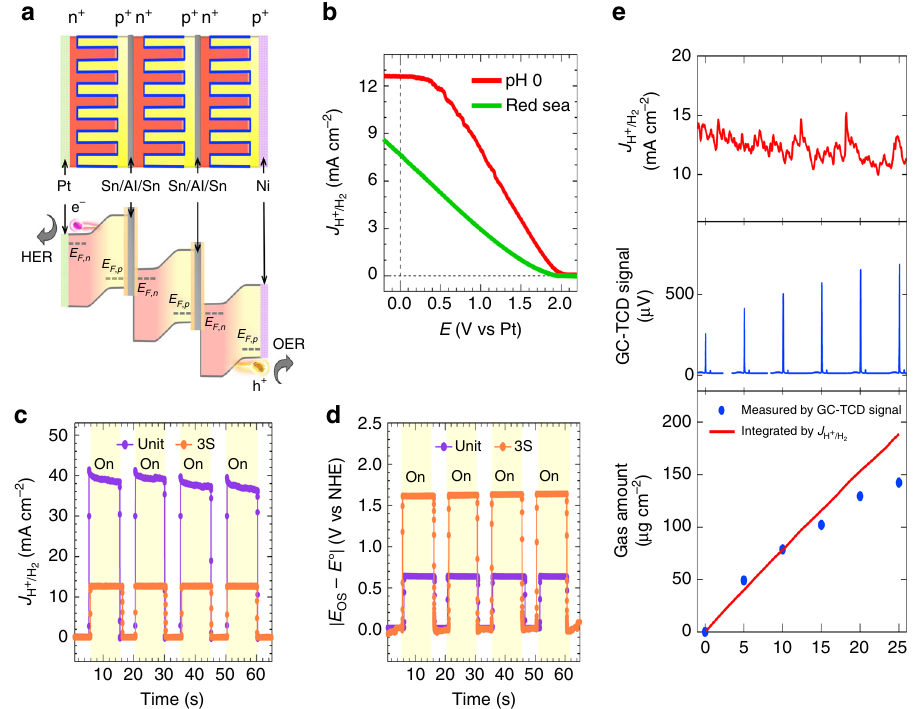
Fig. 4 The characterization of the 3S-BBJ – PEC cell. a The schematic and band pro fi le of the 3S-BBJ – PEC cell. b J – E characteristics of the 3S-BBJ cell in 1 M H 2 SO 4 (red) and Red Sea water (green) electrolytes. c Time-resolved saturated current density and d Time-resolved onset potential of the unit- and 3S-BBJ – PEC cells. e GC measurement of a 3S-BBJ – PEC cell under AM 1.5 G illumination without bias, where the top panel is the J – T curve during the GC measurement, the middle panel is the GC with thermal conductivity detector (GC-TCD) signal of hydrogen, and the bottom panel is the amount of hydrogen evolved as a function of time as calculated by integrating the current by the time (red line), and by the H 2 concentration obtained from the GC-TCD signal (blue dots). PEC performances were measured under simulated AM 1.5 G illumination using a Ag/AgCl reference electrode in 1 M H 2 SO 4